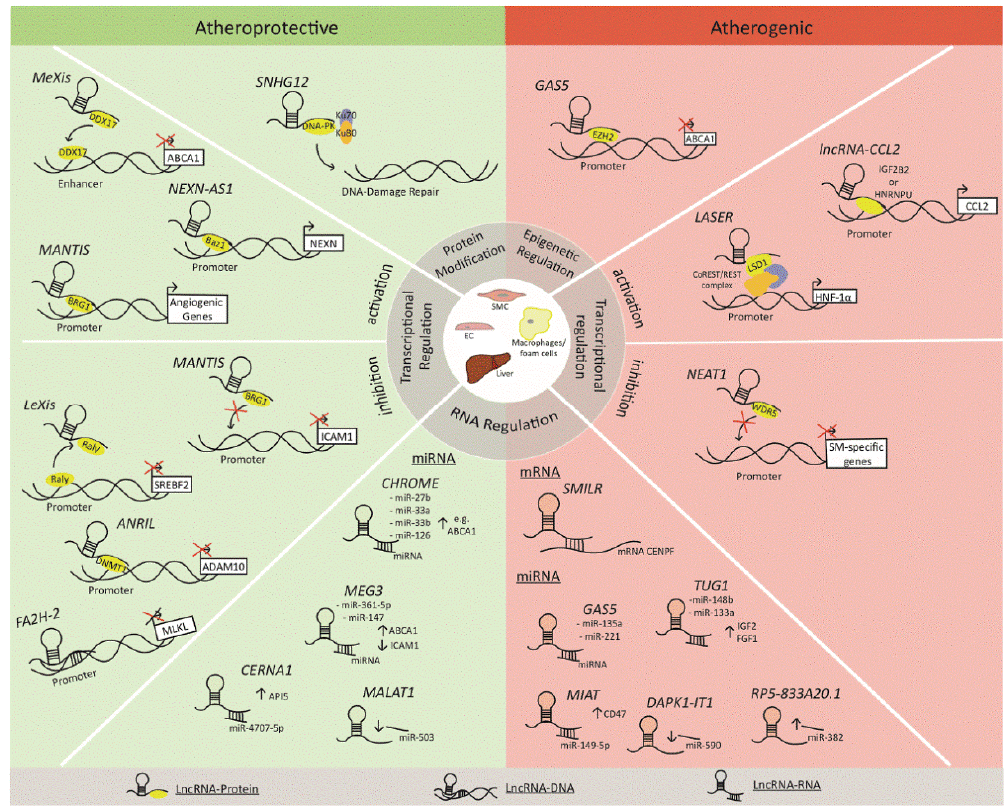
Figure 1. LncRNAs implicated in atherosclerosis (atheroprotective or atherogenic). Reproduced from Josefs et al. Curr.